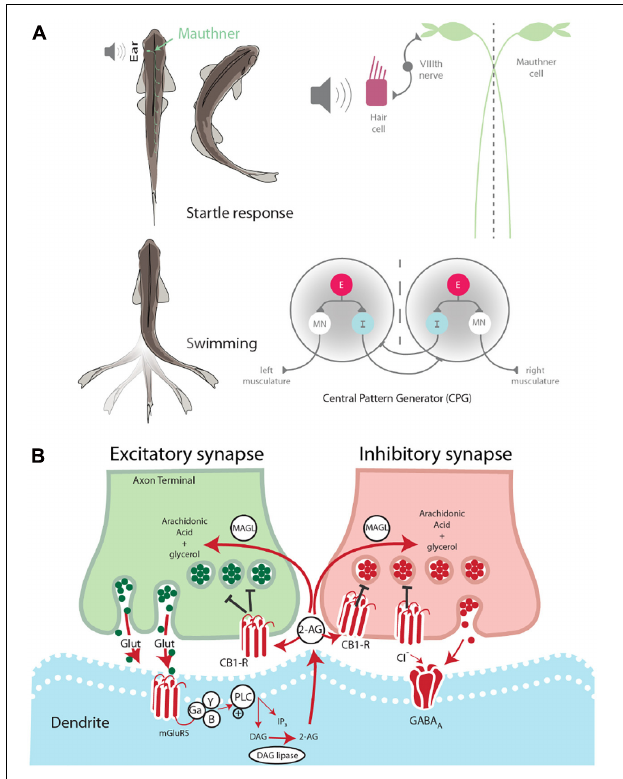
FIGURE 1 | Startle escape and swim motor behaviors are socially regulated. (A) Startle behavior in zebrafish is controlled by the M-cell startle escape circuit. The auditory startle escape response is activated when a sound activates hair cells within the ear. Next, the signal is sent from the VIIIth nerve to the M-cell, which activates contralateral fast motor neurons responsible for contraction of flexor muscles that leads to the startle escape response. The swimming motor pattern is controlled by the central pattern generators (CPGs) which repeat along the length of the spinal cord. Each half-center of the CPG is composed of an excitatory interneuron (E), an inhibitory interneuron (I), and a motor neuron (MN). The motor neurons project ipsilaterally to the trunk musculature and induce contraction. (B) Schematic model of endocannabinoid retrograde signaling. The endocannabinoid 2-AG is synthesized post-synaptically in response to neurotransmitter binding. Traditional model suggests that retrograde transmission of 2-AG inhibits further release from both excitatory and inhibitory neurons. DAG lipase synthesizes 2-AG post-synaptically. CB1 receptor binds 2-AG. MAGL degrades 2-AG in presynaptic